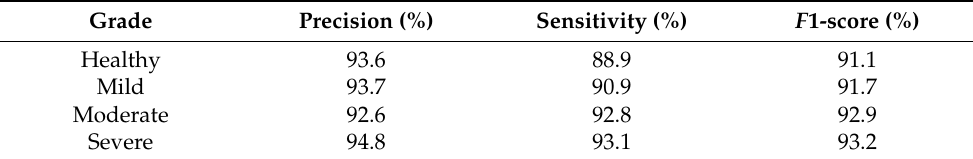
Table 6. Results of precision, sensitivity, and F 1-score for four grades.